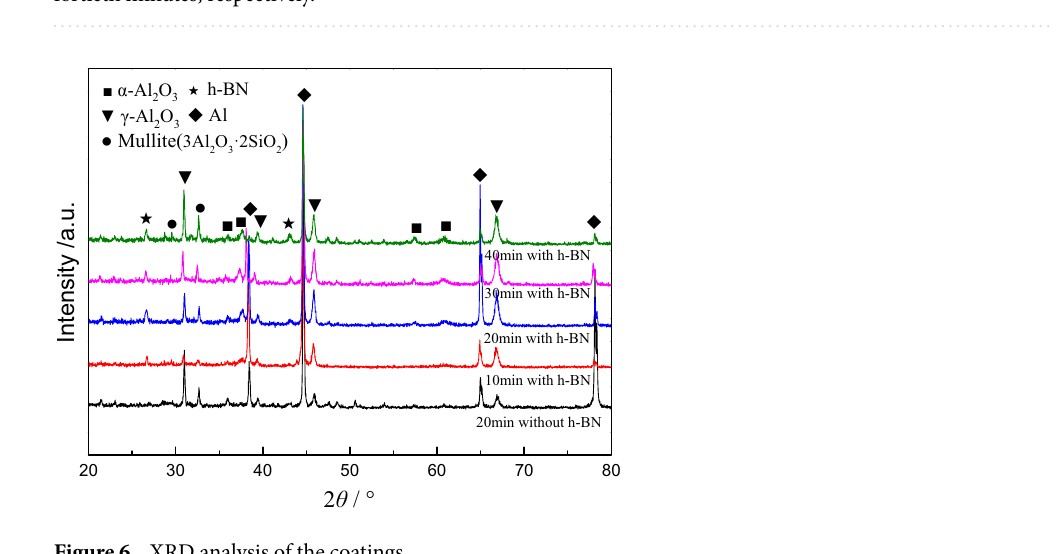
Figure 6. XRD analysis of the